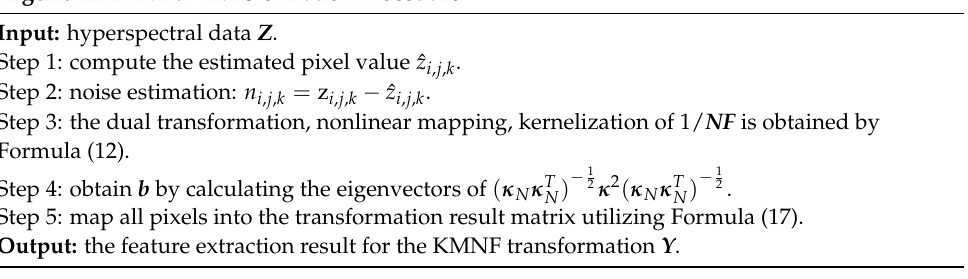
Algorithm 1 KMNF Transformation